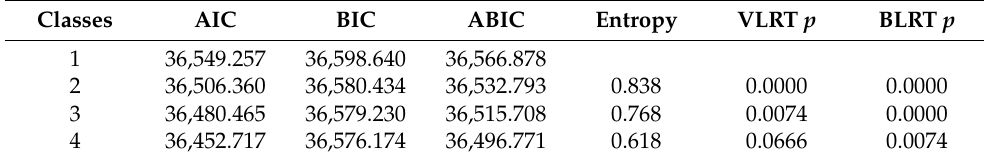
Table 3. Criteria used to decide on optimal solution for number of latent